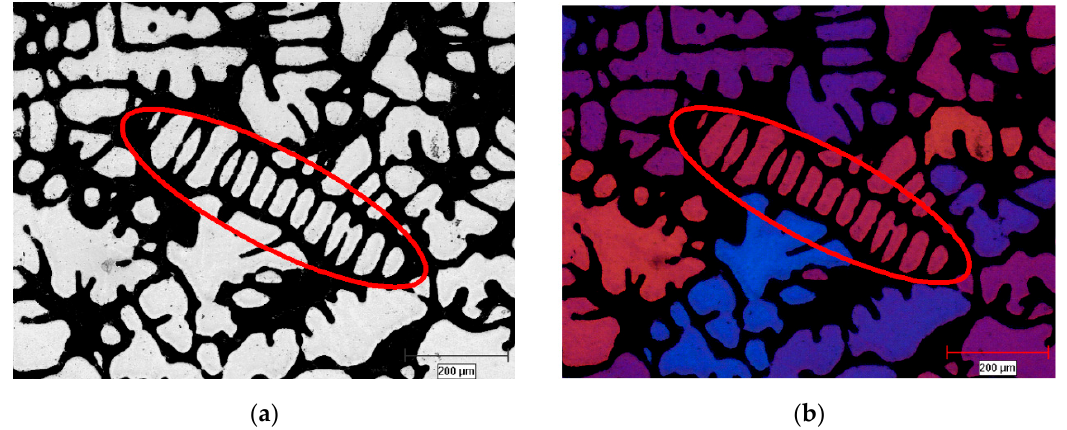
Figure 1. Branches of dendrites, A356 alloy, quenched from 598 °C [1]: ( a ) bright field, and ( b ) polarized light image with sensitive tint plate, polished and anodized with Barker’s reagent.